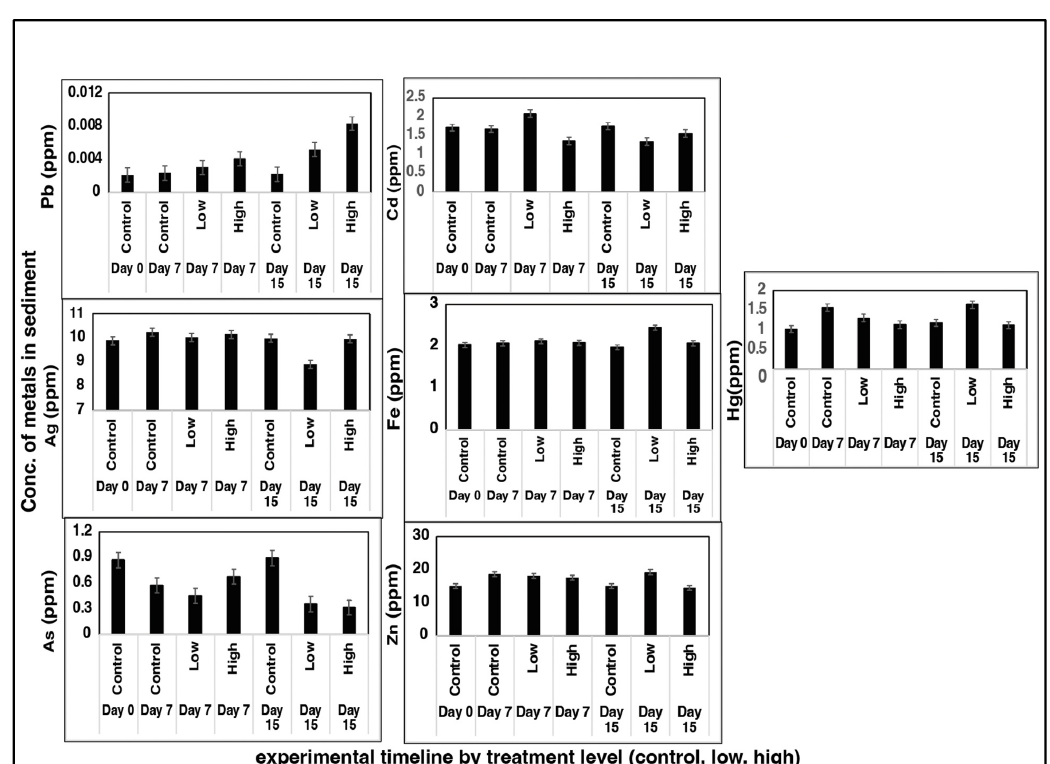
Figure 6. Median concentration of (in ppm) detected sediment metals in metal microcosms (for wet-